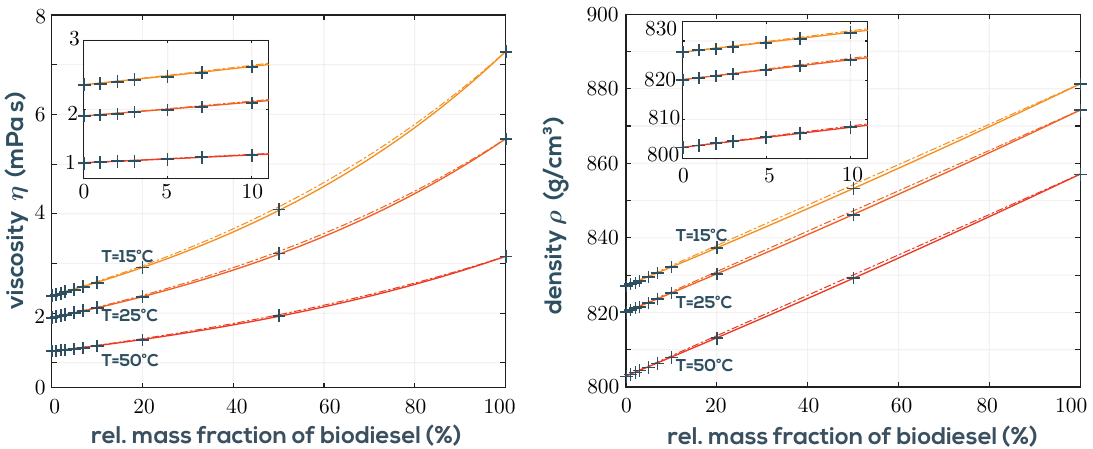
Figure 8. Left : viscosities for varying biodiesel content in fossil diesel. The lines follow a Grunberg–Nissan model in Equation (6). Right : Densities for varying biodiesel content in fossil diesel. The lines are given by the binary mixture model in Equation (7). Dash-dotted lines represent the respective model with fitting parameters α and β set to